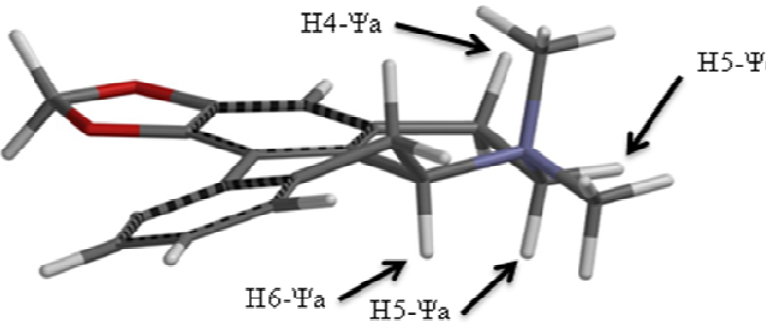
Figure 2. Spartan energy minimized structure of